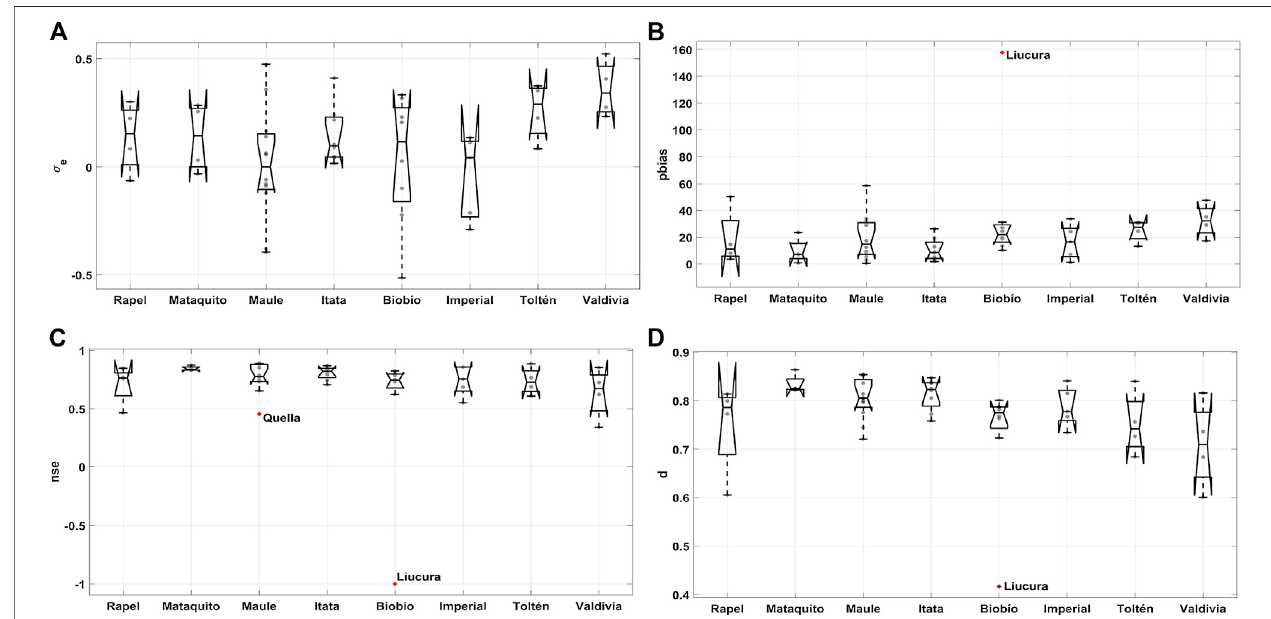
FIGURE 13 | Annual cumulative rainfall. (A) Rainfall observed and (B) dynamic topo-climatic model.